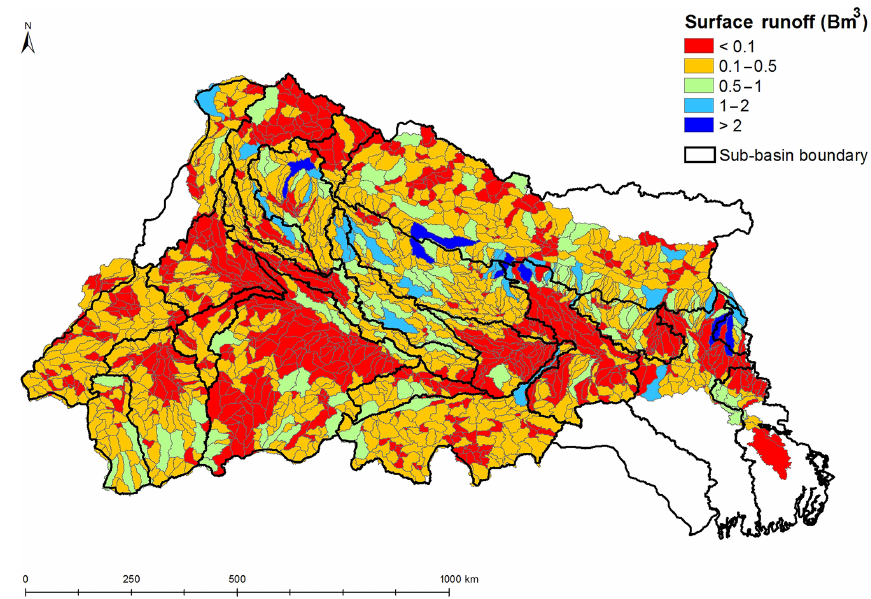
Figure 2. Mean annual runoff of the 1684 sub-basins